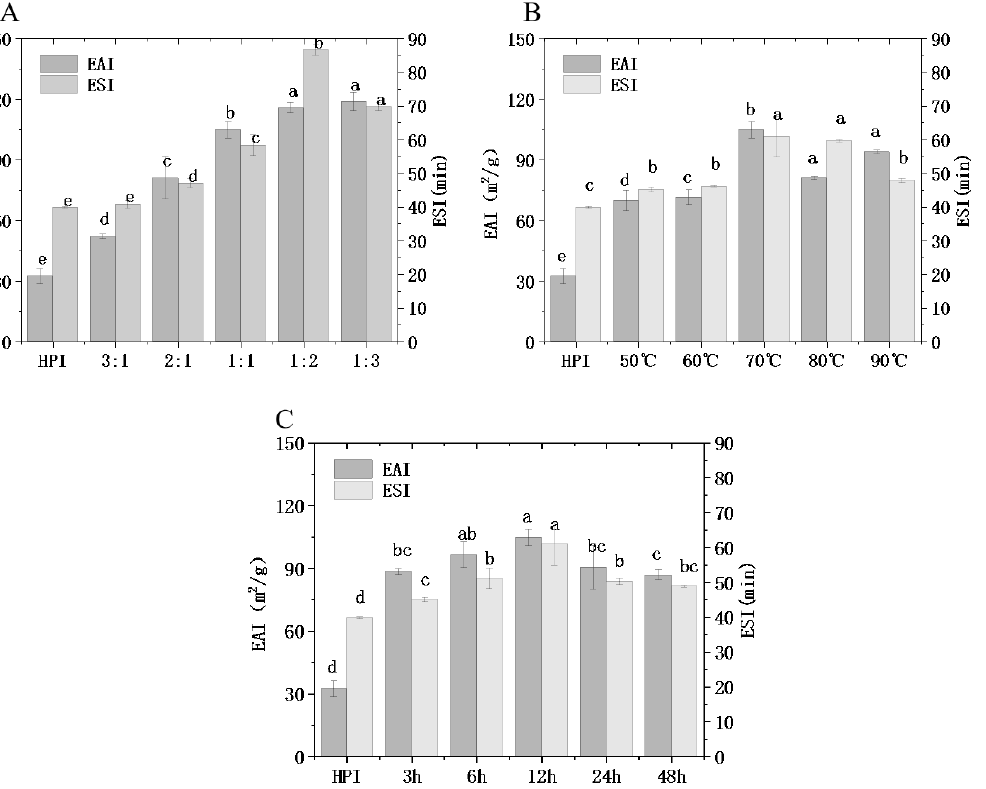
Figure 5. Effect of hemp protein isolate (HPI) ratios to pullulan ( A ), incubation temperature ( B ), and incubation time ( C ) on the emulsification ability of glycosylated HPI. Different superscript letters represent a significant difference ( p < 0.05). EAI: emulsifying activity index. ESI: emulsion stability index.